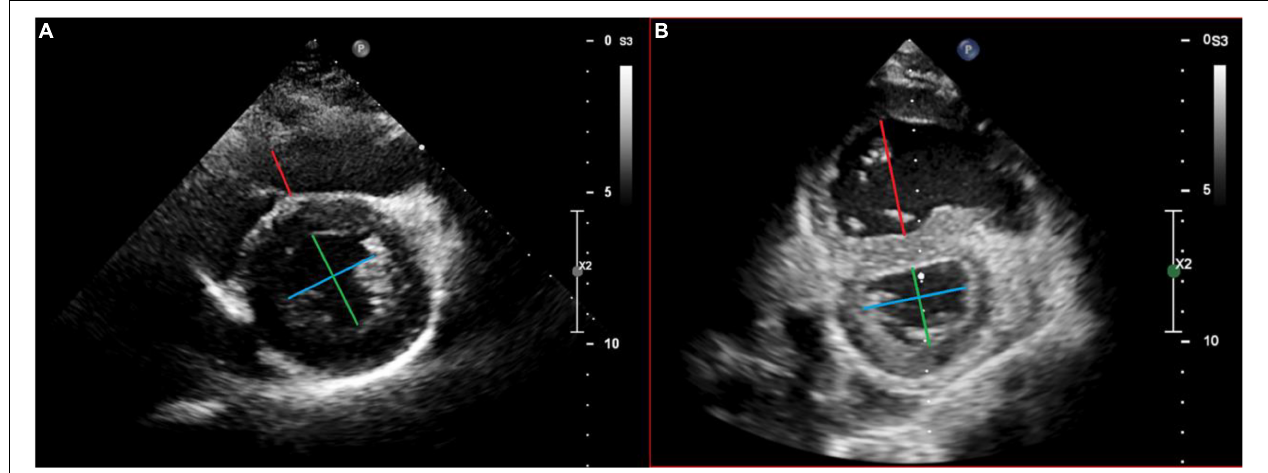
FIGURE 1 | Echocardiographic measurement of the right ventricular to left the ventricular endsystolic (RV/LVes) ratio and the left ventricular endsystolic eccentricity index (LVes EI) in a healthy subject (A) and in a patient with pulmonary hypertension (B) . Measurement of the RV/LVes ratio (RV = red/LV = green line) and the LVes EI (blue/green line) in the apical parasternal short axis view between papillary muscle, from the endocardial to endocardial surfaces at